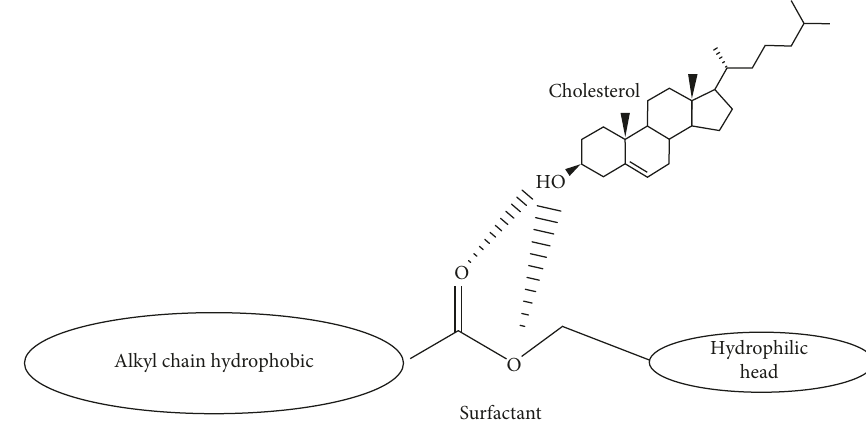
Figure 3: Schematic structural interaction between surfactant and cholesterol.